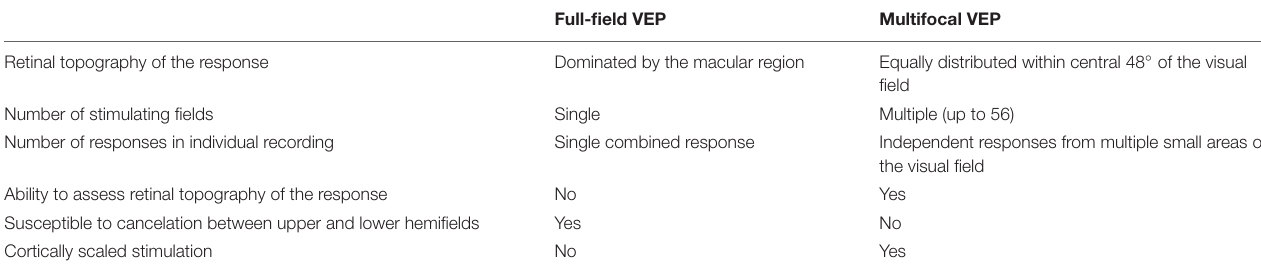
TABLE 1 | Comparison between full-field and multifocal